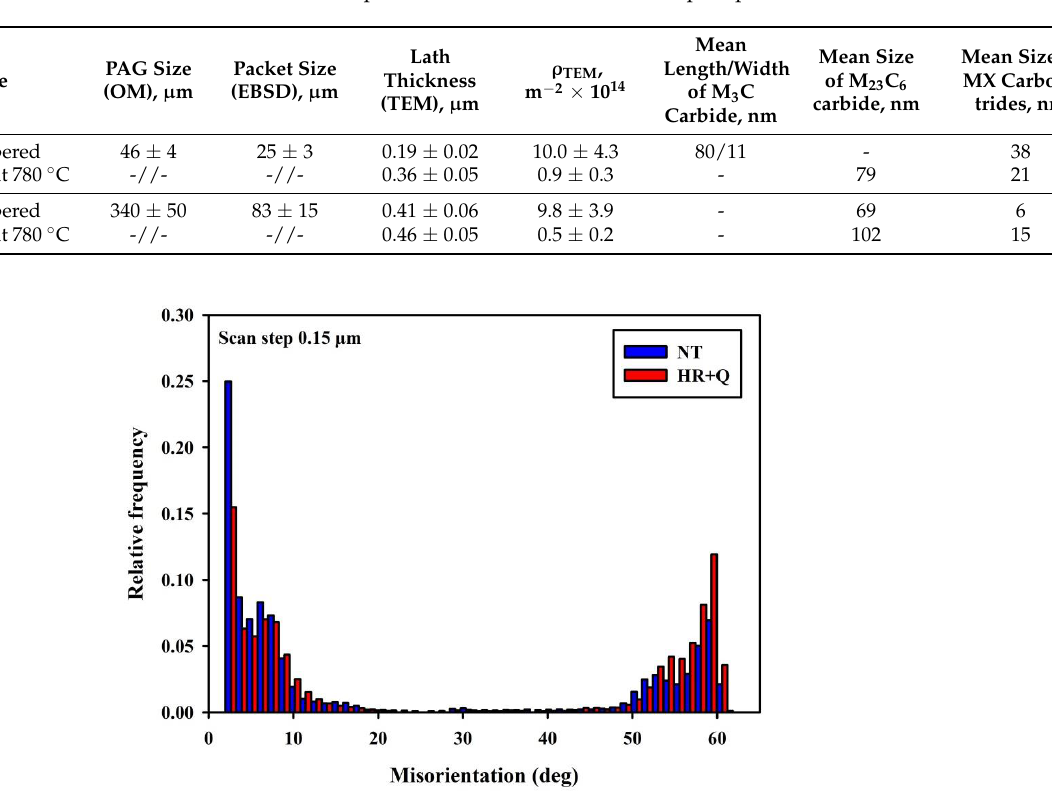
Table 2. Microstructural parameters and the mean size of precipitates in the NT and HR+Q samples.